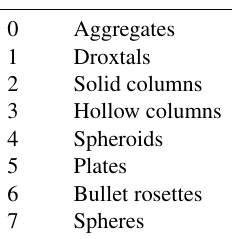
Table E1. Ice crystal shapes in the netCDF file and the correspond- ing